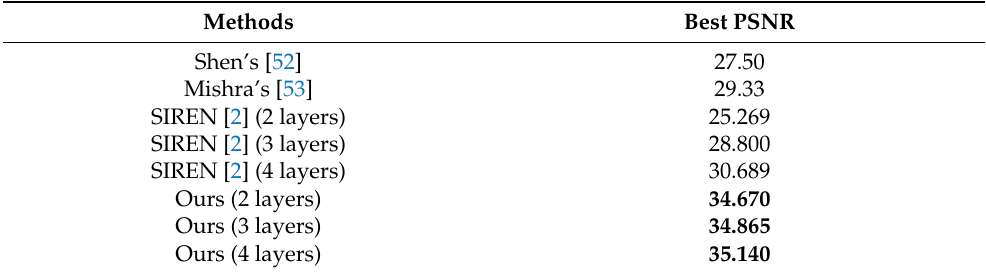
Table 7. Comparison of results of our technique with SIREN [2], Mishra’s [53] and Shen’s [52] in terms of